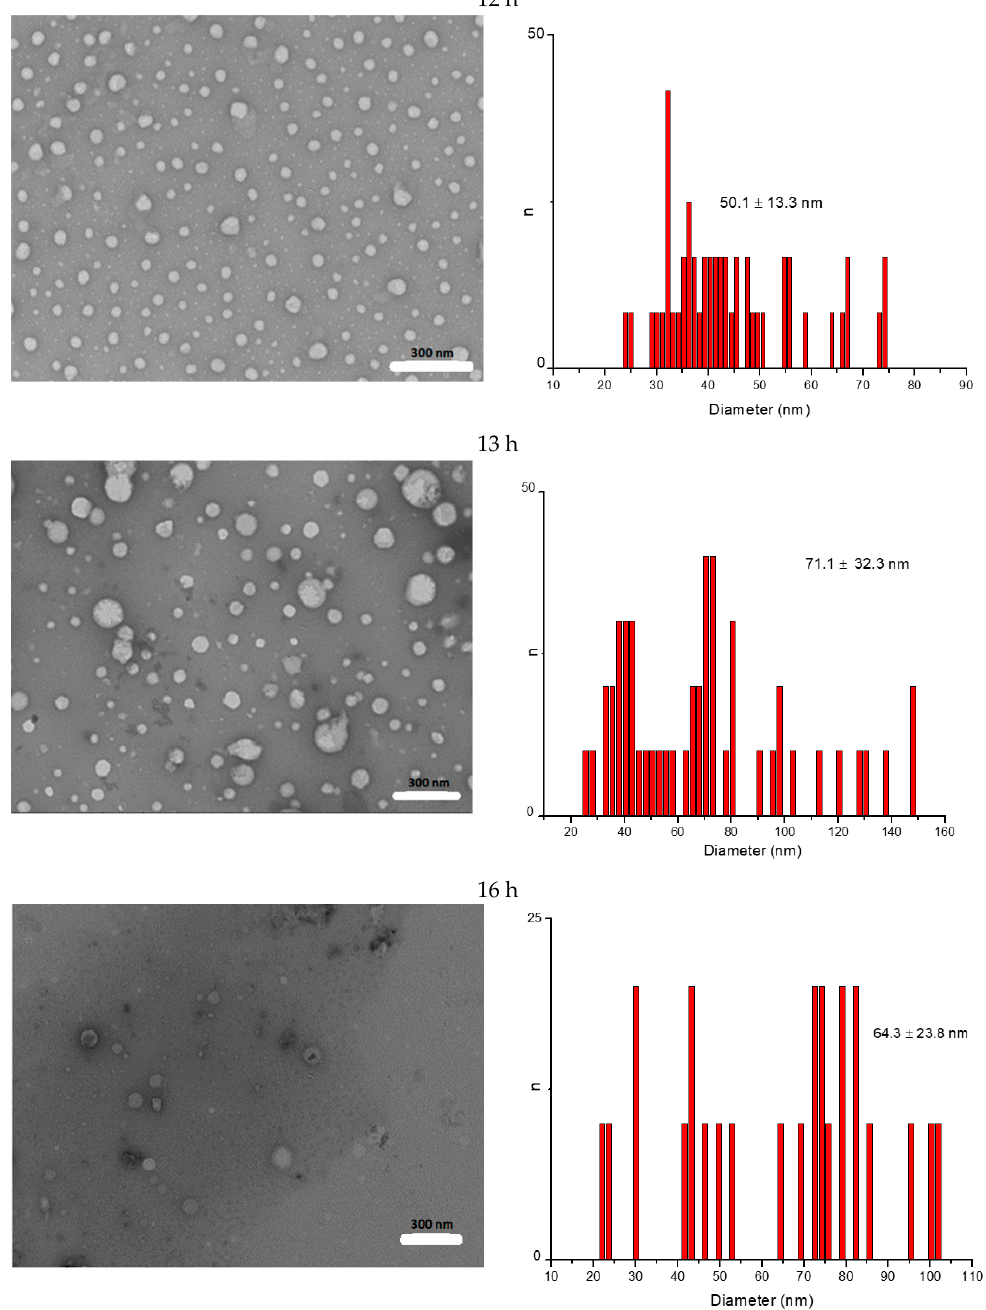
ff erent irradiation